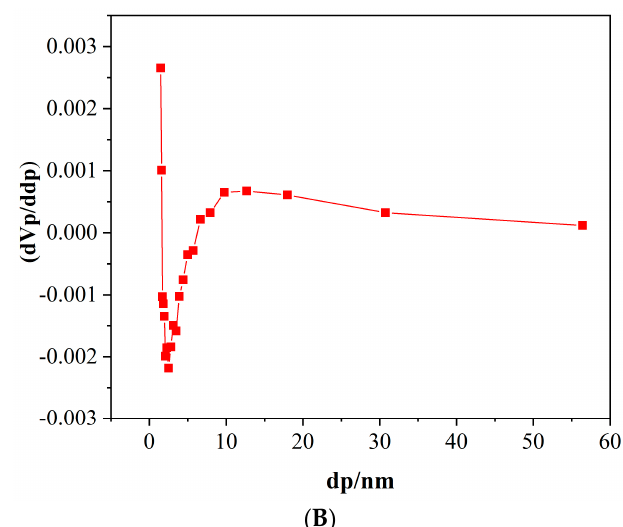
Figure 6. ( A ) N 2 adsorption/desorption isotherms at − 196 °C for Fe 3 O 4 /AC/CD/Alg polymer beads. ( B ) Pore size distribution of Fe 3 O 4 /AC/CD/Alg polymer beads.